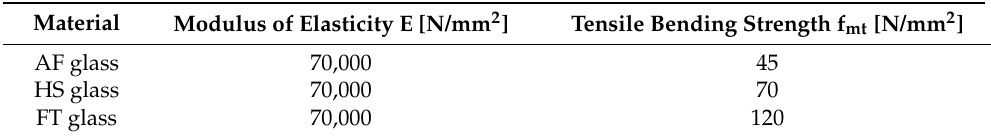
Table 4. Material properties of used structural glasses